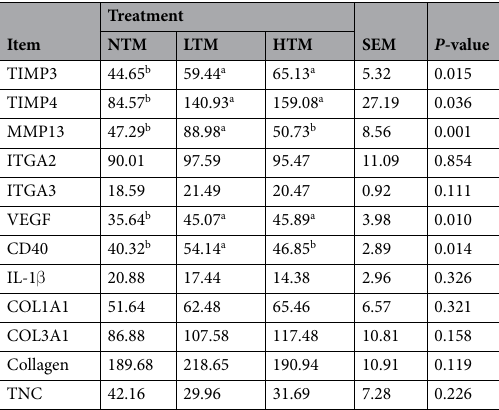
Table 5. Relative mRNA levels of the genes potentially associated with footpad dermatitis wound healing as measured by Area under the curve in broilers fed three supplemental trace mineral levels during d15 to 43 of age. a,b Means within a row with different superscripts differ at P < 0.05. Reported standard error of the mean (SEM) is the average SEM of the individual least-square